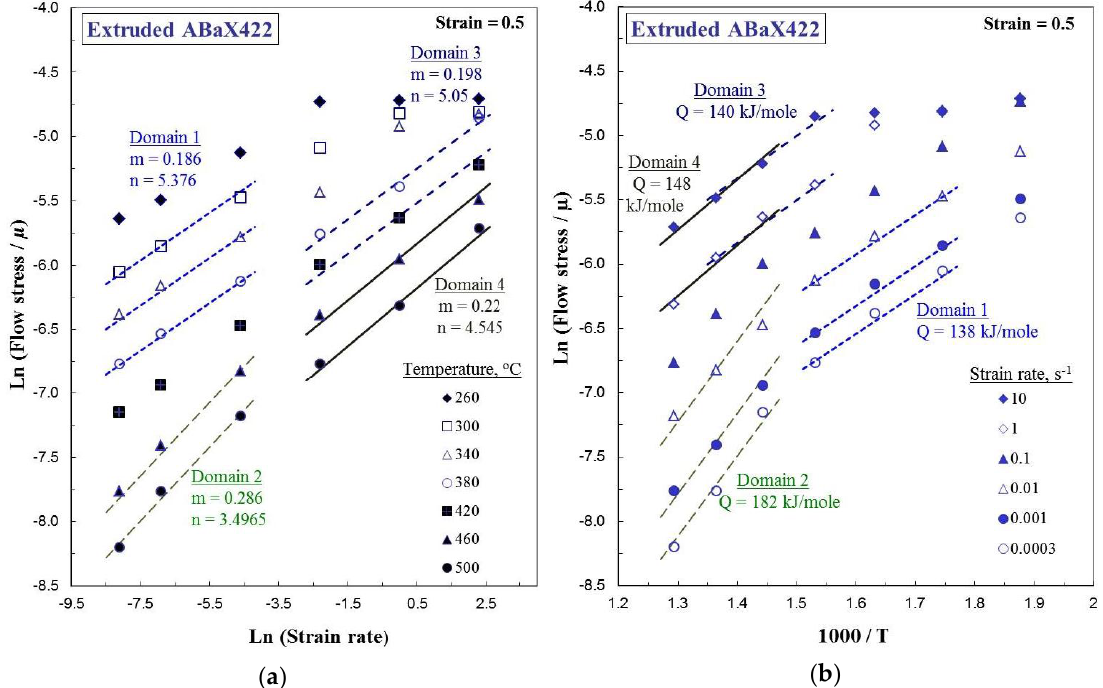
Figure 9. ( a ) Variation of normalized flow stress with strain rate on natural logarithmic scale, and ( b ) an Arrhenius plot of normalized flow stress with the inverse of absolute temperature. The apparent activation parameters n and Q are estimated with data relevant to various domains of the processing map for the extruded ABaX422 alloy.